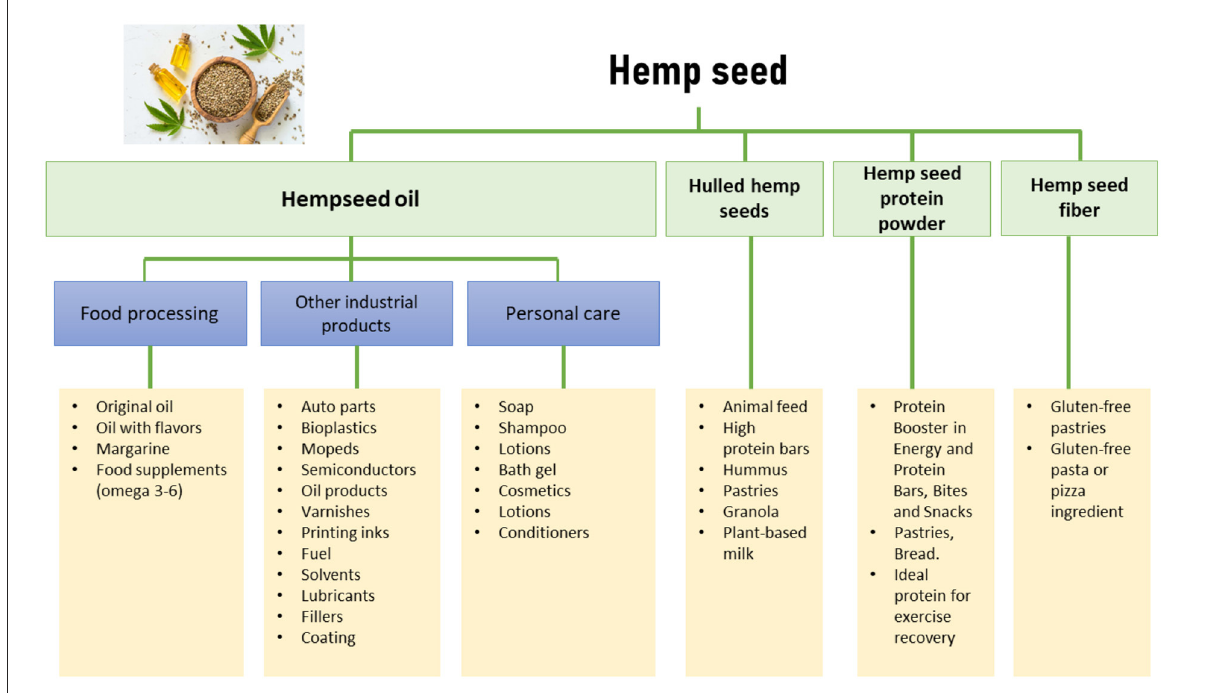
FIGURE4 Uses and applications of hemp seed in different sectors (Modified from: New Frontier